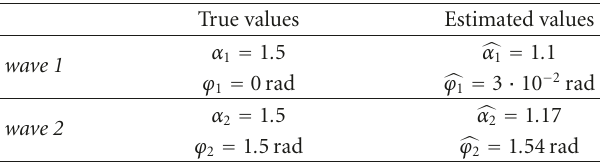
Figure 12: Upper plot = modulus of diagonals of blocks (1) and (4) diagonals of the spectral matrix of wave 1 (Figure 8). Bottom plot: angle of blocks (2) and (3) diagonals of the spectral matrix of wave 1 (Figure 8).